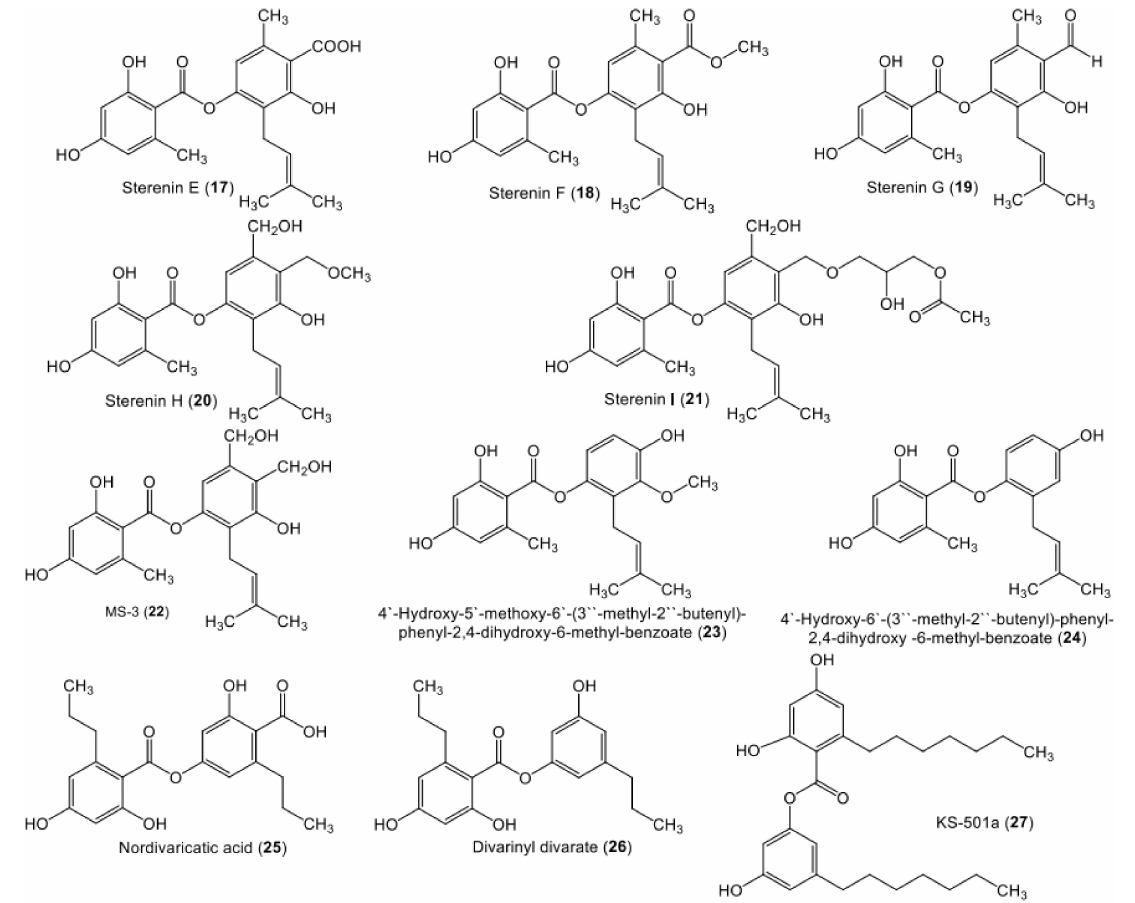
Figure 4. Chemical structures of di-depsides 17 – 27